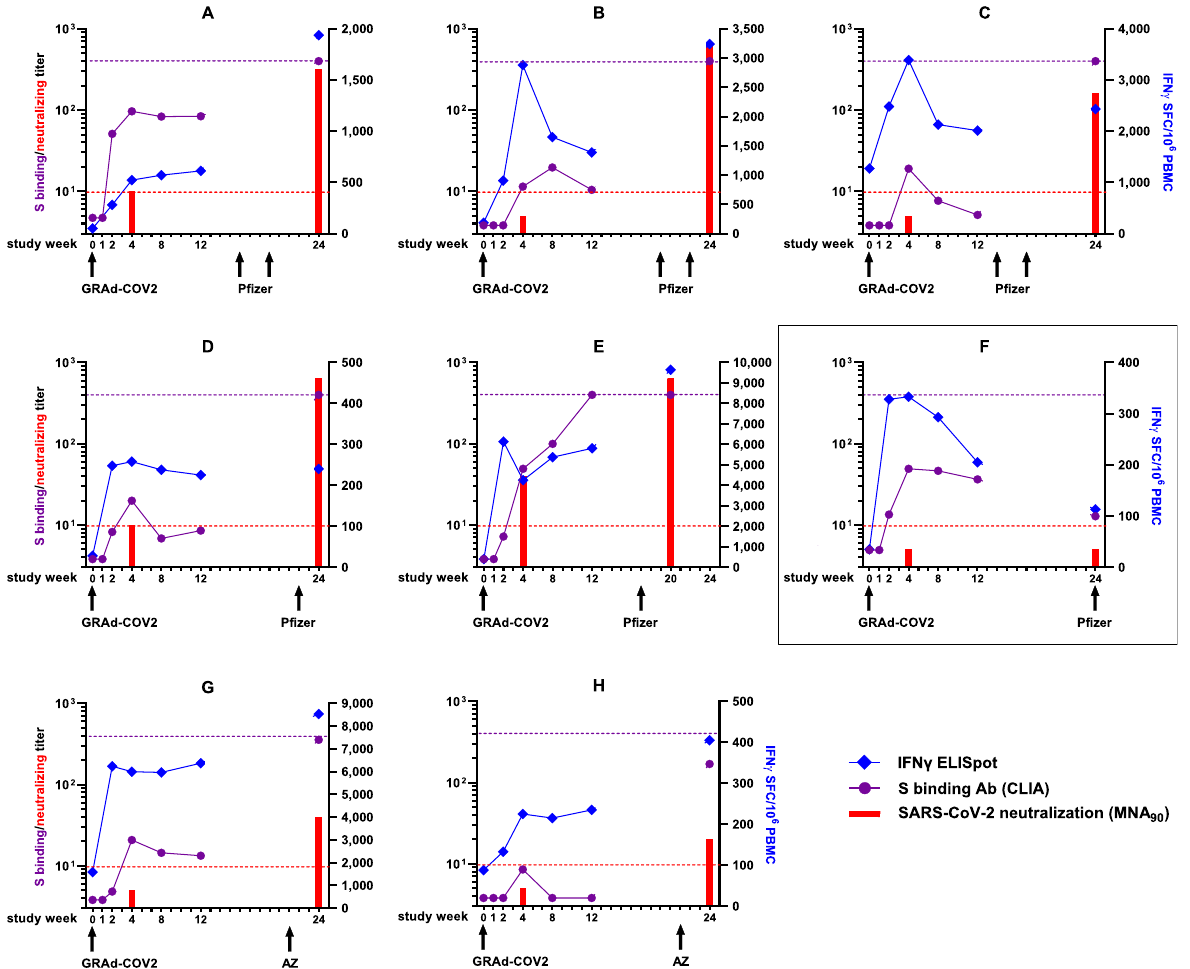
Fig. 1 Immunogenicity pro fi le of GRAd-COV2-vaccinated volunteers receiving approved COVID-19 vaccines. Each graph corresponds to an individual volunteer, as indicated by the code in the graph title. Subjects who received 2 doses of P fi zer (Panels A-C), 1 dose of P fi zer (Panels D-F) or 1 dose of ChAdOx1 (Panels G-H) are shown. Arrows at the graph bottom indicate study week when each GRAd-COV2 or P fi zer (BNT162b2)/AZ (ChAdOx1-nCoV19) vaccination was received. Numbers on the x axis indicate timing in weeks from GRAd-COV2 vaccination when a study visit occurred. The purple round symbols indicate Spike-binding IgG levels, as measured by CLIA assay and expressed in arbitrary units (AU)/ml. The red bars at w4 and 24 show SARS-CoV-2-neutralizing antibody titers, expressed as MNA 90 . Both serological endpoints are plotted against the left y axis. Purple dotted line set at 400 AU/ml indicates the upper limit of quanti fi cation for CLIA. Dotted red line indicates positivity threshold for the MNA assay, i.e., a neutralization titer of 1:10 or higher is deemed positive. The blue diamond symbols show Spike-speci fi c T-cell response as measured by IFN γ ELISpot, expressed as IFN γ spot forming cells (SFC)/million PBMC, and plotted against the right y axis. The box highlights the subject F, receiving the booster dose only three days before the week-24